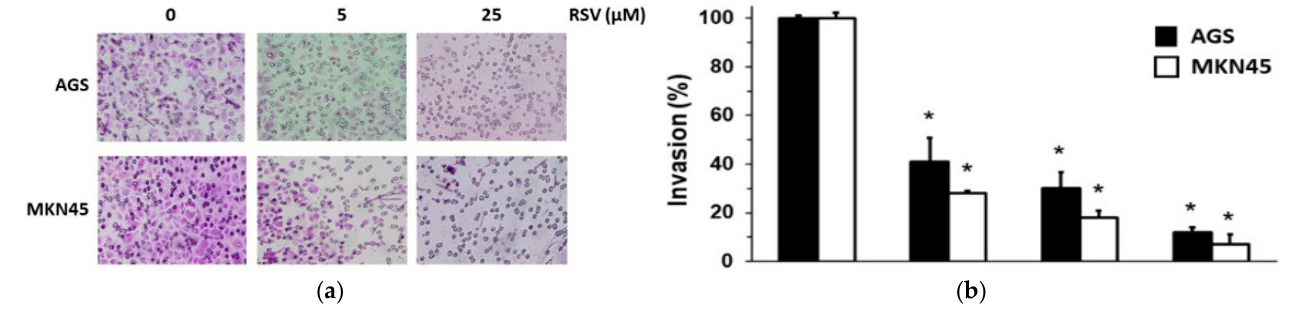
Figure 2. Effect of RSV on invasion potential of gastric cancer cell lines. AGS and MKN45 gastric cancer cells were treated with different concentrations of RSV (5–25 μ M) for 24 h and then harvested and seeded into the upper compartment of the Boyden’s invasion chamber. The number of cells that moved into the lower chamber represented the invading cells. ( a ) After the RSV treatment, repre- sentative pictures of the invasion assay in AGS and MKN45 cells were presented (magnification ×100). ( b ) Bars represent the percentage of the invasion of AGS (black column) and MKN45 (white column) cells treated with different doses of RSV compared to the control ethanol-1%-treated cells (control 100% invasion). Data represent means ± S.D. of three independent experiments. * p < 0.001 vs. control.